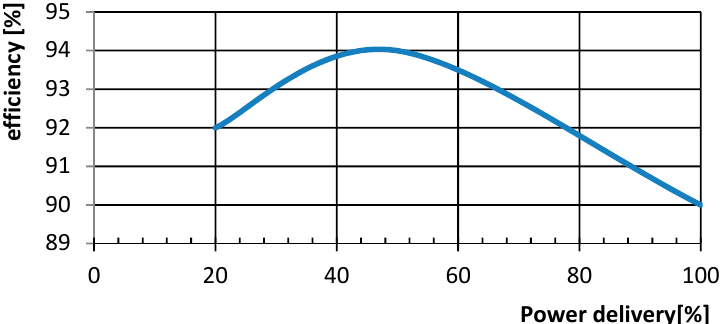
Figure 5. Efficiency curve of standard DC/DC converter stage.